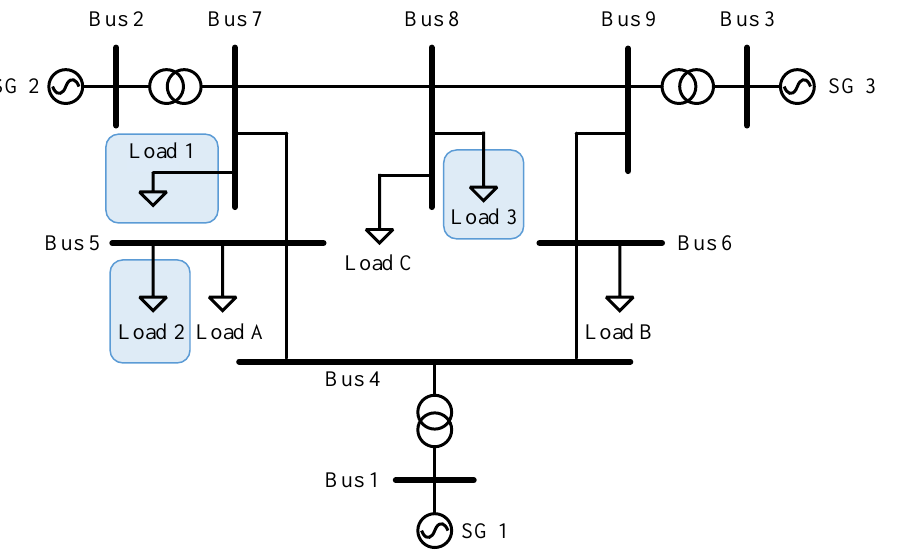
Figure 8. Single-line diagram of the benchmark IEEE 9-bus system , where the induction motors are replaced with the equal capacity constant loads.